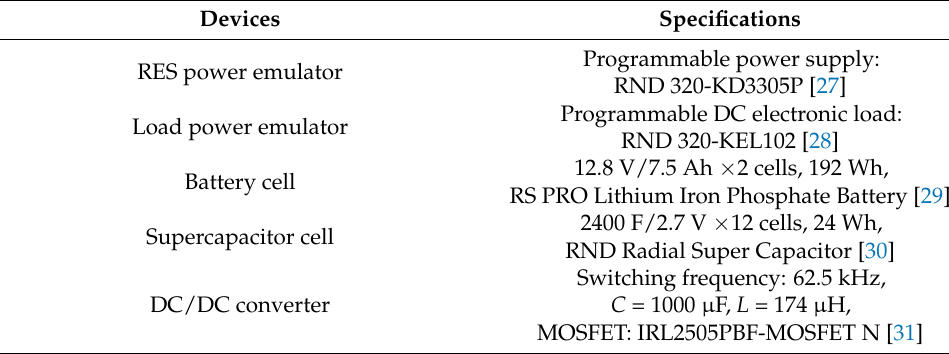
Table 3. Nominal parameters of the experimental devices.